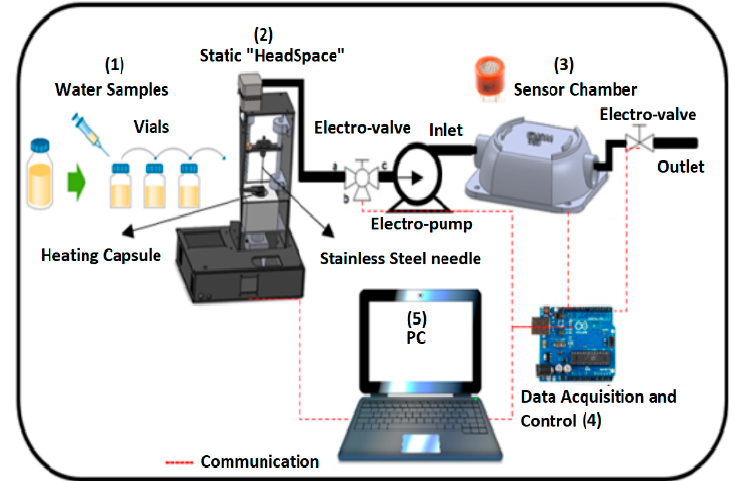
Figure 1. Scheme of the measurement system.